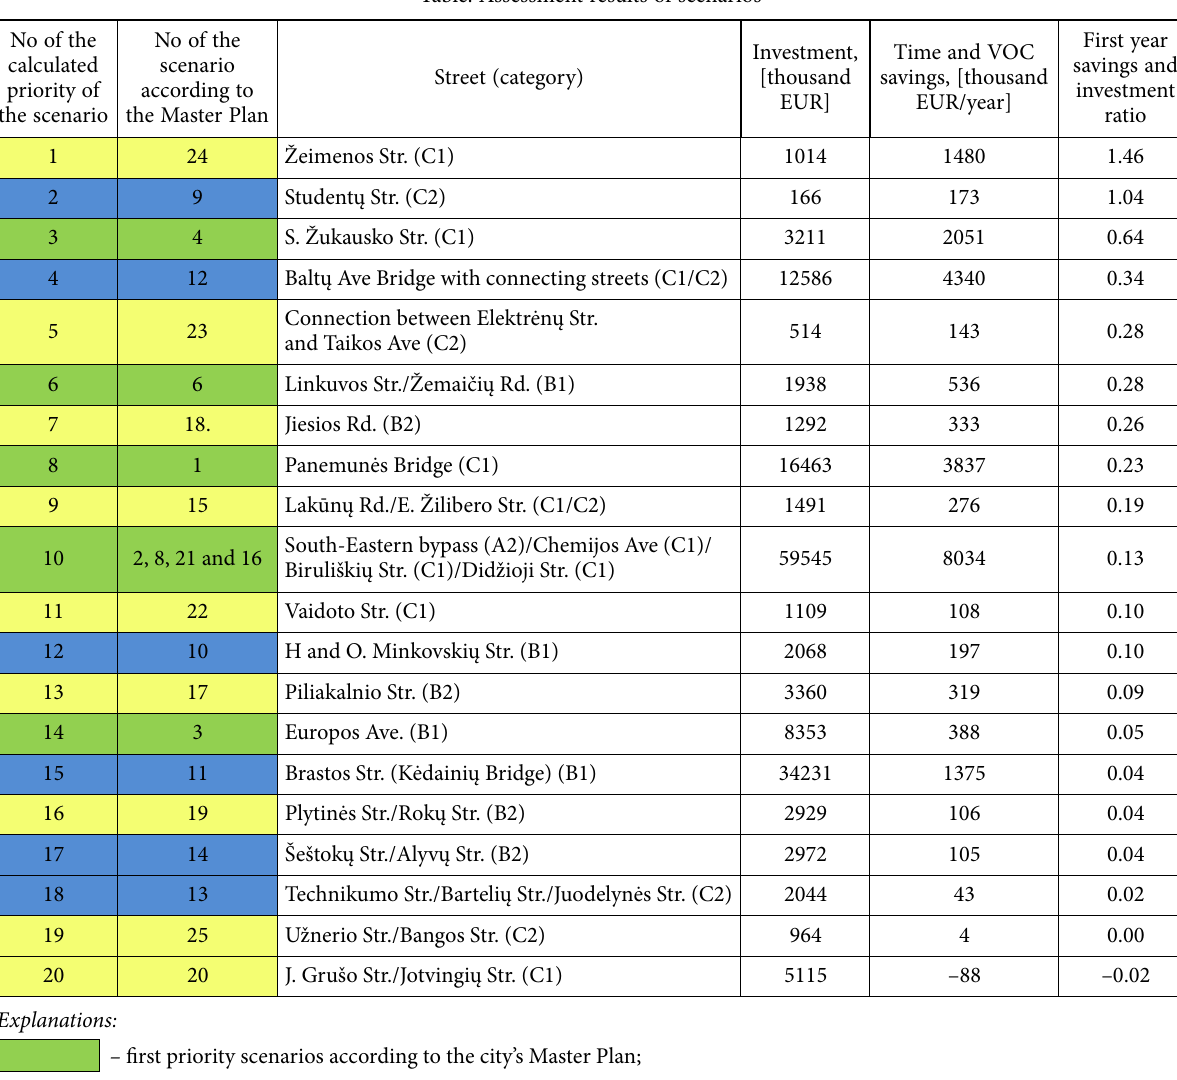
Table. Assessment results of